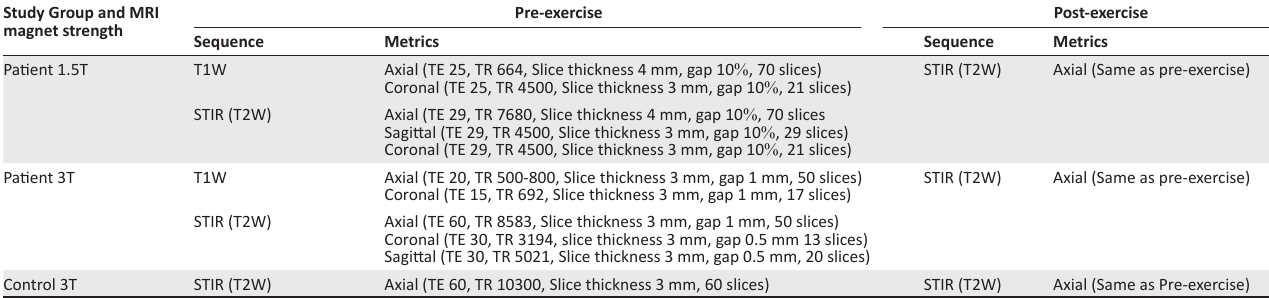
TABLE 1: MRI sequences obtained in patients and control groups. Study Group and MRI magnet strength